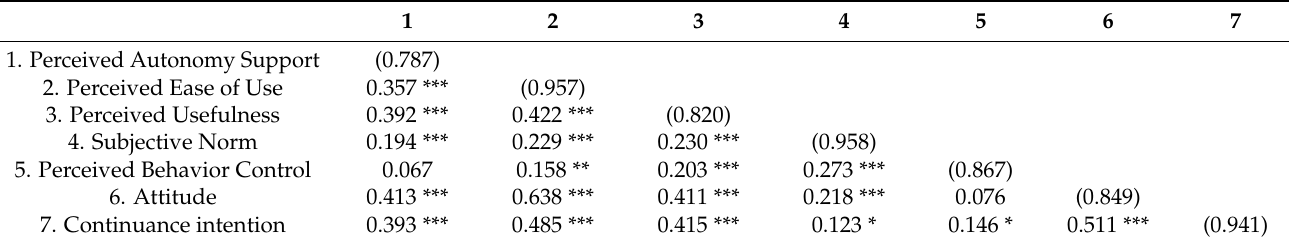
Table 3. Discriminant Validity Analysis